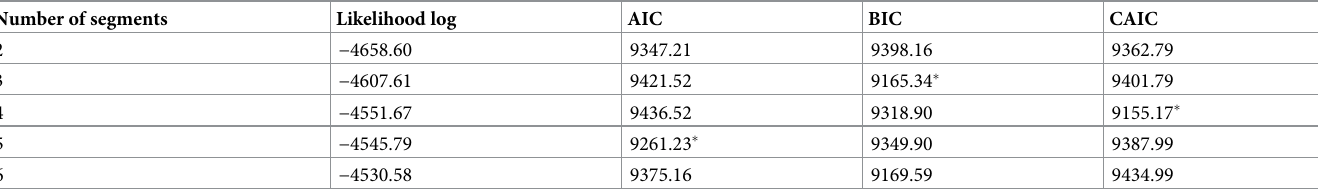
� indicates the lowest values of AIC, BIC, and